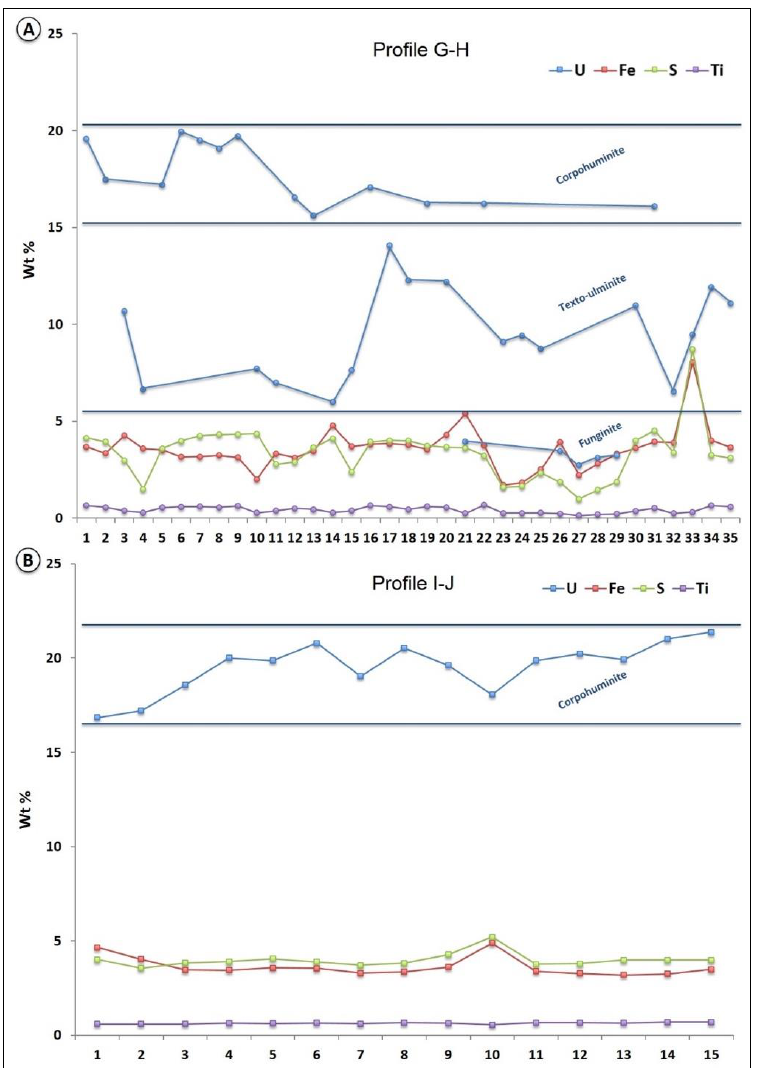
Figure 6. The profiles G-H and I-J presented in Figure 5. Profile G-H ( A ) indicates that the composition of uranium in corpohuminite is more than double that of the texto-ulminite background, reaching 19 wt %. Sulfur and iron concentrations are not perfectly correlated and several datapoints show antagonistic behavior. Profile I-J ( B ) was performed on a single corpohuminite particle and shows that uranium concentration is between 16 and 22 wt %. Sulfur and iron are sub-constant and correlated, which could be related to pyrite nanocrystal inclusions. Titanium is sub-constant and around 1 wt % for both